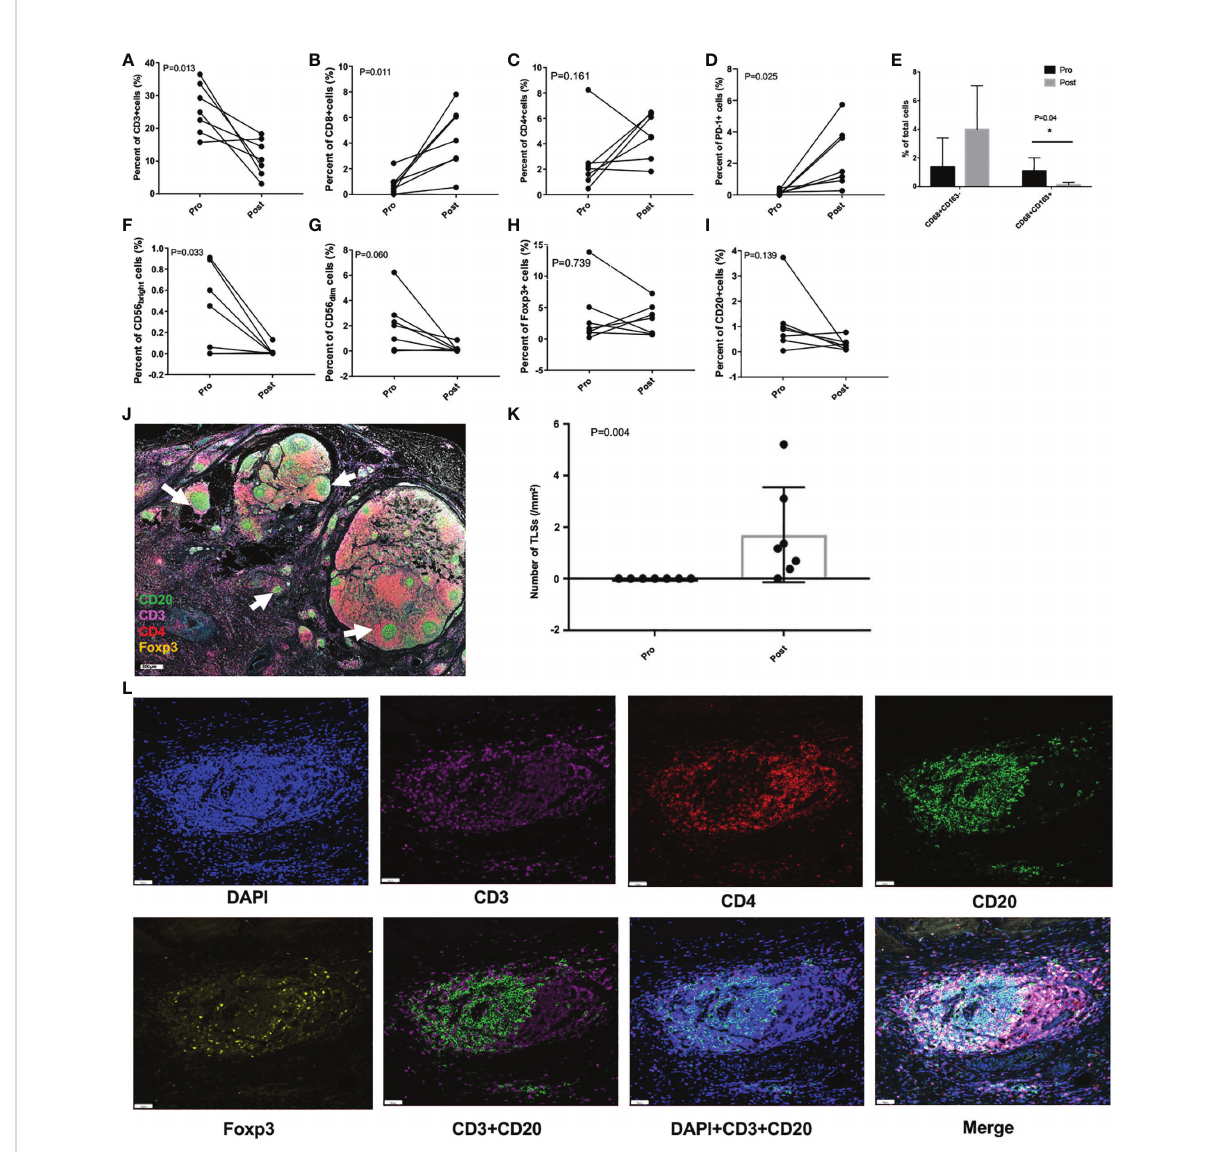
FIGURE 4 Tumor immunity in the microenvironment pre- and post- intra-arterial chemotherapy. (A-I) Per cent changes of different immune cells before and after treatment. (J) Representative immuno fl uorescence image of resected tumor specimen after treatment, and the white arrows indicate the tertiary lymphoid structures (TLSs; scale: 500 m m). (K) The number of TLSs before and after the treatment. (L) Images of representative TLSs (scale: 50 m m) *P <